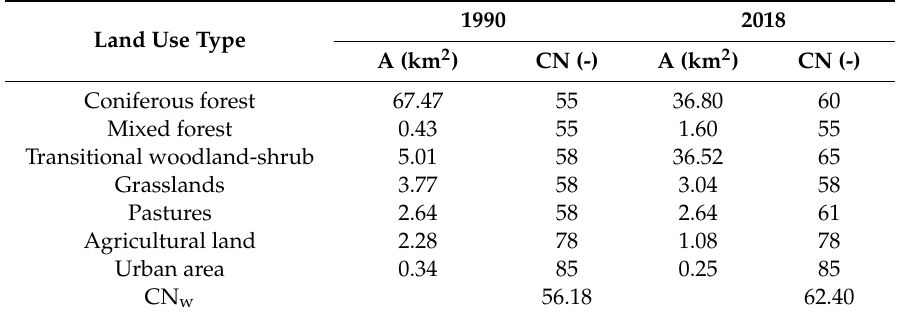
Table 8. The selected values of the CN parameter for the Boca Basin (A–basin area; CN–Curve Number value; CN w –weighted CN value).